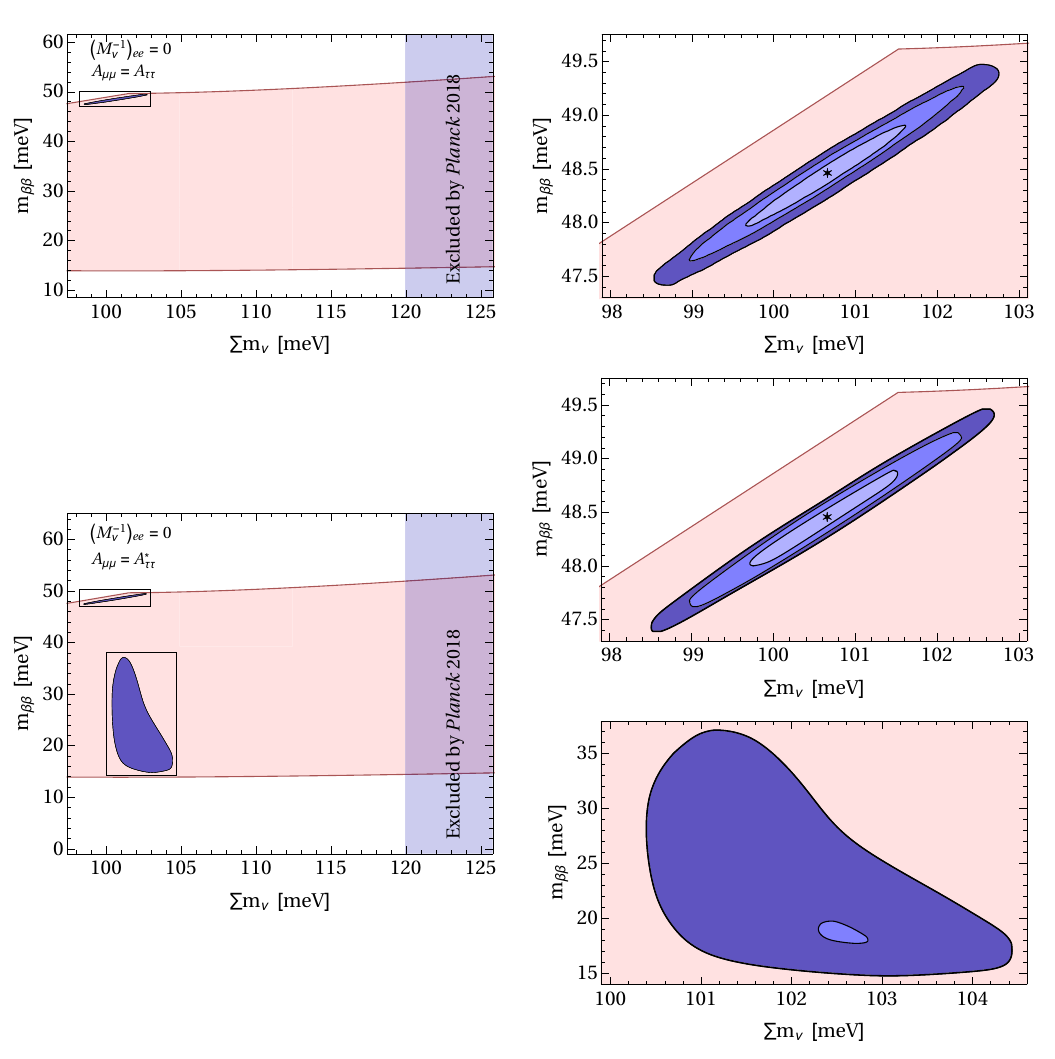
Figure 8 . The predictions of models 6 (top row) and 7 (the other two rows) for the sum of the light-neutrino masses and for the mass parameter responsible for neutrinoless 2 (cid:12) decay. The pink areas are the ones allowed by phenomenology alone, for an inverted ordering of the neutrino masses; the blue areas include the constraints of each model. The right panels are zooms of the marked areas in the left